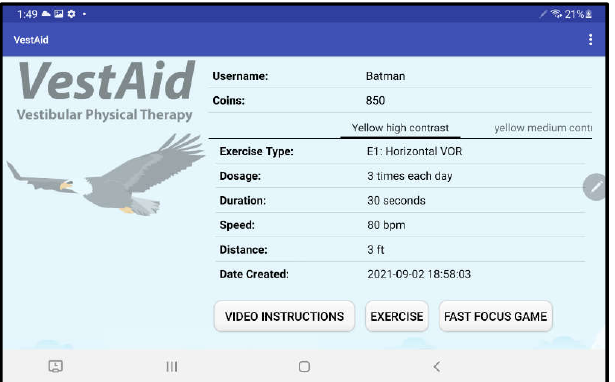
Figure 2. VestAid start page.